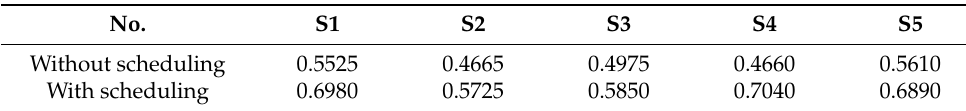
Figure 9. Users’ satisfaction with five scheduling actions. The horizontal axis indicates users’ instantaneous satisfaction, and the vertical axis denotes probability (Blue columns represent users’ satisfaction without scheduling, and red columns represent users’ satisfaction with scheduling). Table 8. CS with and without scheduling.